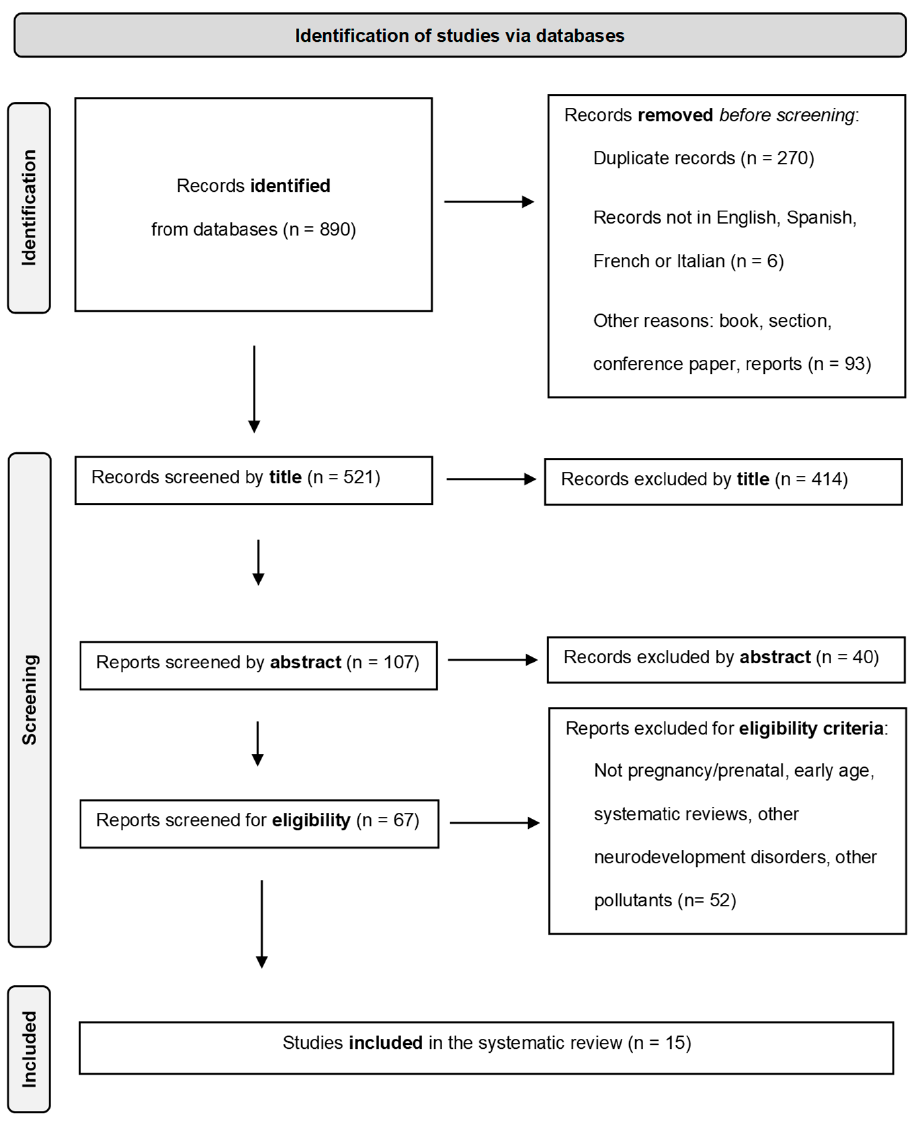
Figure 1. PRISMA-2020-based fl ow diagram of the selection process in the systematic review.